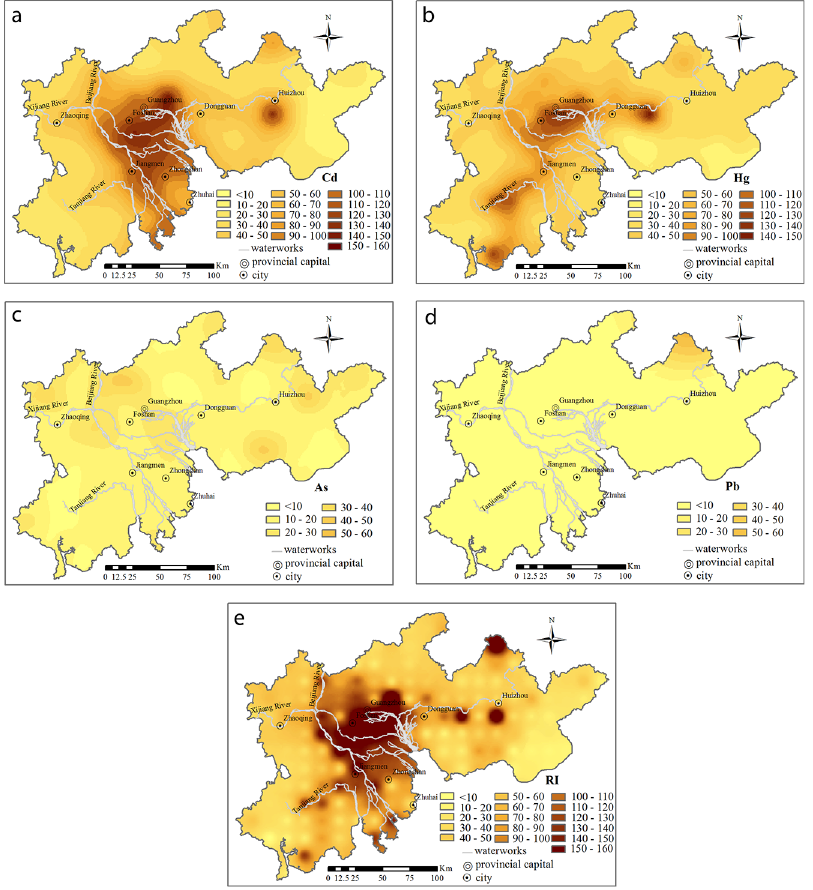
Fig 7. Potential risk index (RI) of heavy metals in the soil of the PRD. (a) Cd; (b) Hg; (c) As; (d) Pb; and (e) the four heavy metals.